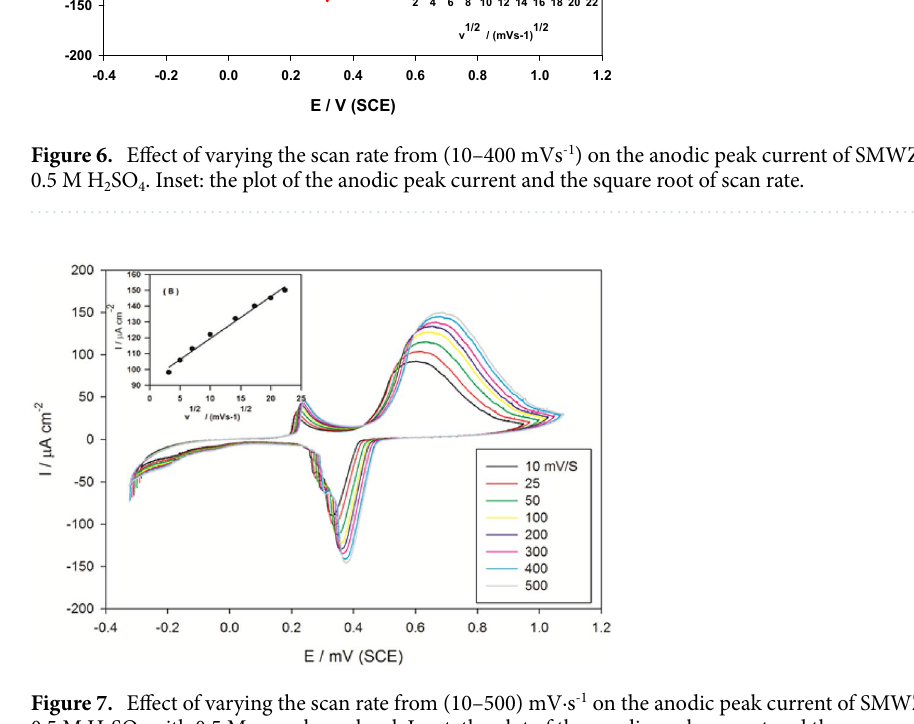
Figure 7. Effect of varying the scan rate from (10–500) mV·s -1 on the anodic peak current of SMWZCPE in 0.5 M H 2 SO 4 with 0.5 M propylene glycol. Inset: the plot of the anodic peak current and the square root of scan